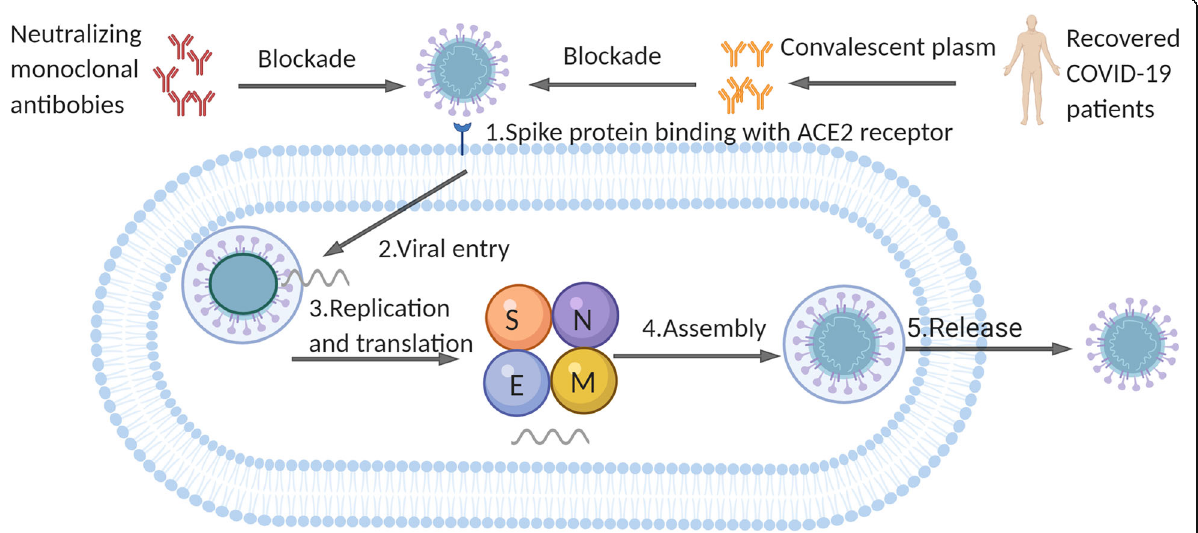
Fig. 4 The hypothetic process of viral invasion into host cells and mechanisms of neutralizing antibodies. Binding of S protein and ACE2 receptor mediates the attachment of SARS-CoV-2 to host cells. After viral entry, the genomic RNA is released into cytoplasm to serve as a template. Then, large amounts of structural proteins S (spike protein), N (nucleocapsid protein), E (envelop protein), M (membrane protein) and genetic materials are synthesized through replication and translation. Finally, the assembled viruses are released to infect host cells nearby. Importantly, neutralizing antibodies existing in convalescent plasm show functions at blocking the adhesion of SARS-CoV-2 with ACE2 by binding the RBD region of S protein competitively. S: spike protein; N: nucleocapsid protein; E: envelop protein; M: membrane